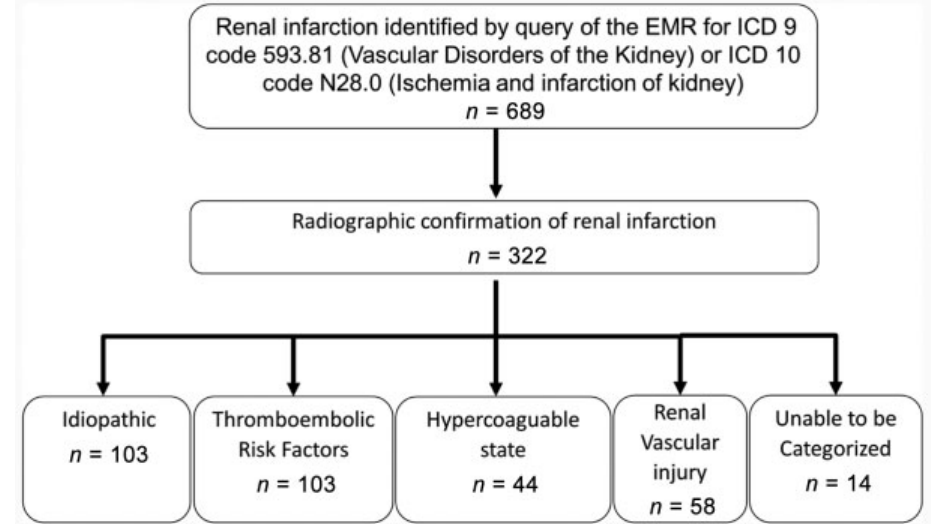
Fig. 1 A fl ow diagram of idiopathic renal infarction case selection. Table 1 Baseline characteristics of cases before renal infarction overall and divided into treatment groups